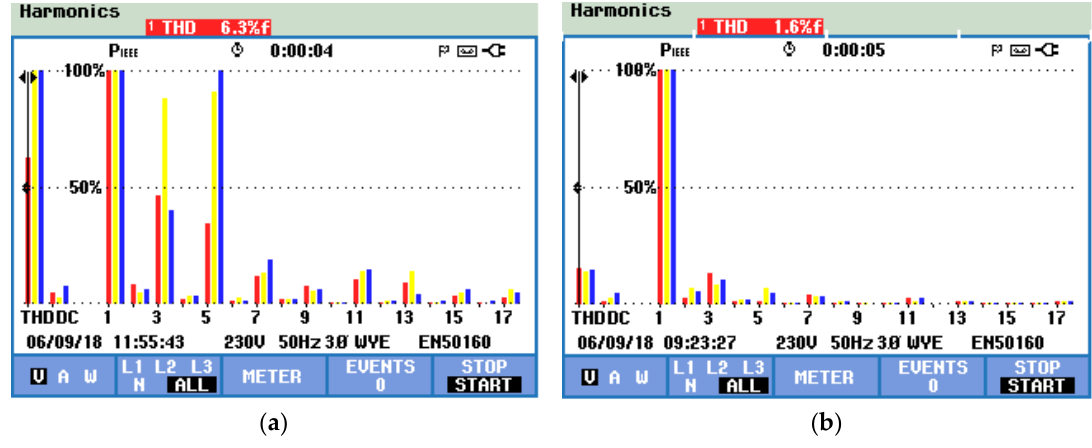
Figure 31. ( a ) THD for non-linear load. ( b ) THD for linear load.